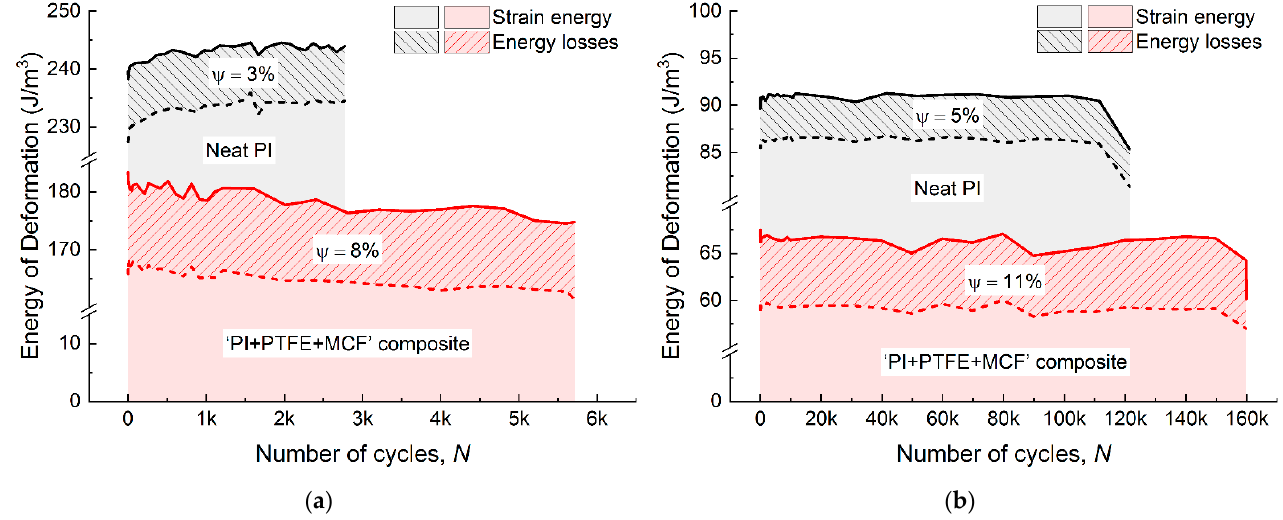
Figure 11. The total strain energy, energy losses and damping capacity for neat PI and the “PI/PTFE/MCF” composite; LCF mode with σ = 1.3 of the yield point ( a ) and HCF mode with σ = 0.7 of the yield point ( b ). Table 3. The energy parameters of fatigue tests for neat PI and the “PI/PTFE/MCF” composite.